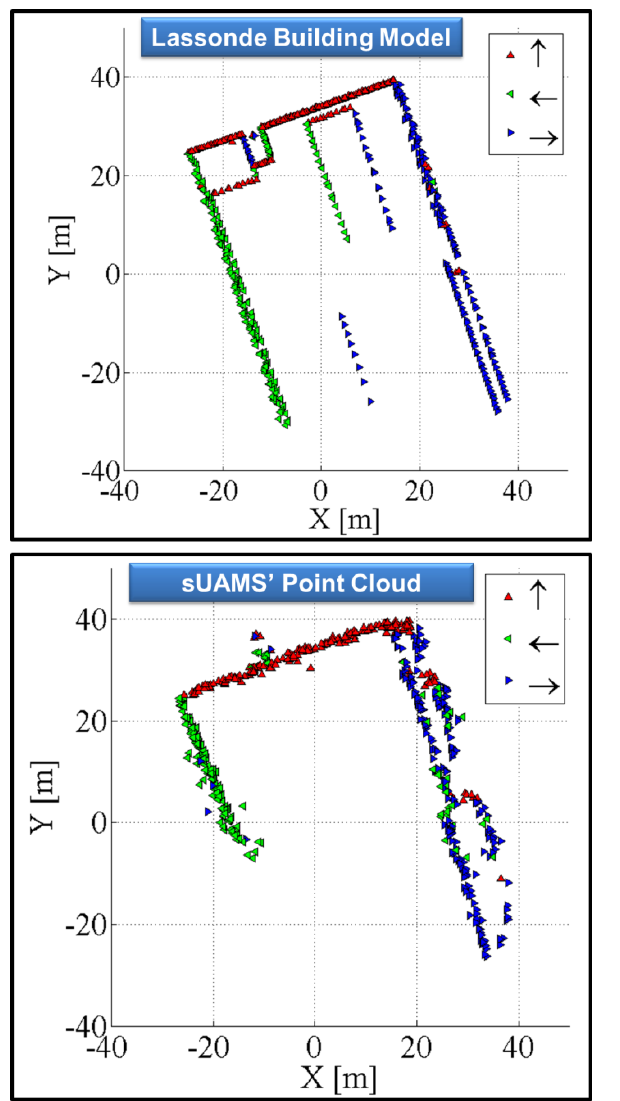
Figure 7: Segmentation of the Lassonde building model (top) and corresponding point cloud generated from the sUAMS’ data (bottom). Points are segmented into three groups based on their normal vector: Group 1 (red triangles): normals pointing in the positive Y direction (±45 o ), Group 2 (green triangles): normals pointing in the negative X direction (±45 o ), and Group 3 (blue triangles): normal pointing in the positive X direction (±45 o ).